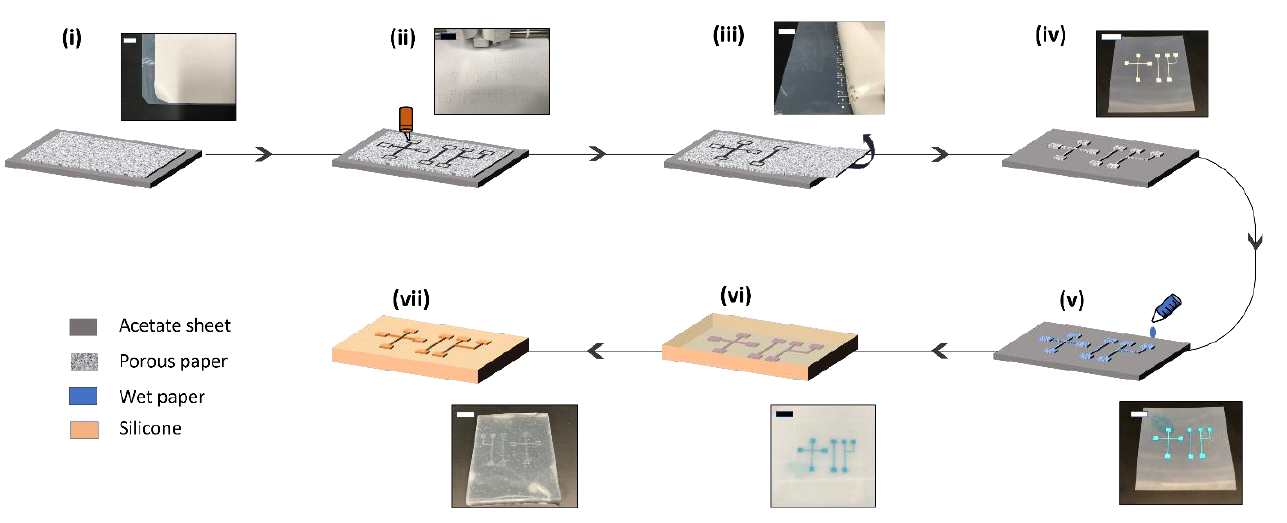
Figure 2. Fabrication workflow of the wet paper molding process. The mold fabrication only requires a cellulose paper sheet, an acetate sheet and a vinyl cutter. A sticky paper is laid on an acetate sheet ( i ) and a digital vinyl cutter is used to cut the mold shapes ( ii ). After carefully peeling off the background ( iii ), the dry molds are inspected for desired cutting operation ( iv ). Measured aliquots of water are pipetted on the molds and allowed to wet the paper through capillary action ( v ). Polymer mix is added on top ( vi ) and after curing, the chips is pulled from the mold ( vii ). The scale bars represent 1.5 cm for ( i – iii ) and 5 mm for ( iv – vii ).